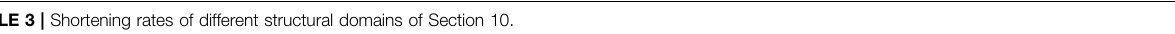
TABLE 3 | Shortening rates of different structural domains of Section